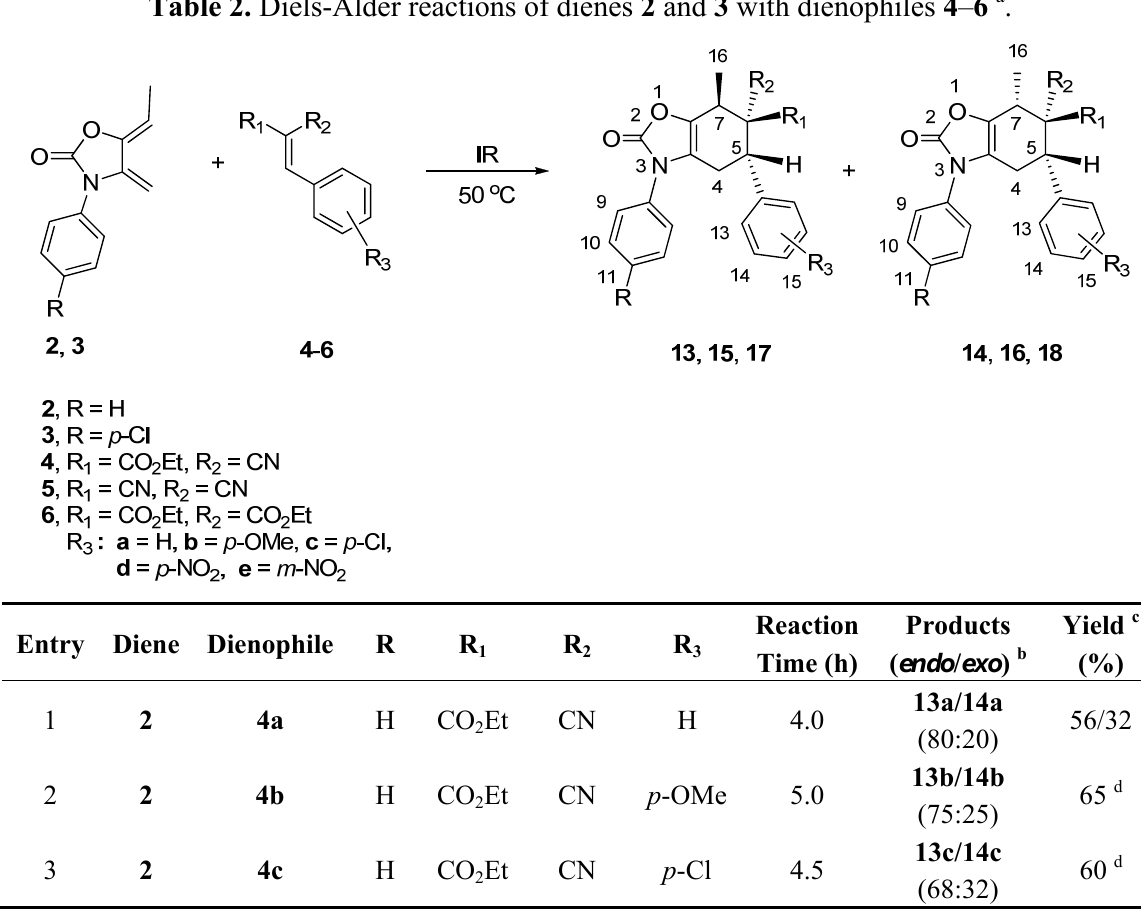
Table 2. Diels-Alder reactions of dienes 2 and 3 with dienophiles 4 – 6 a